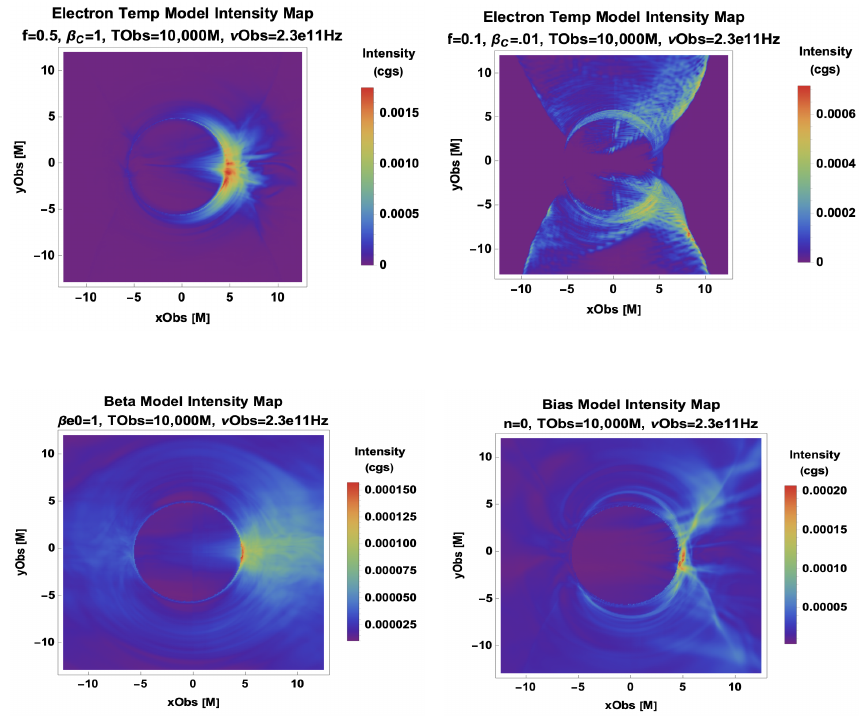
Figure 5. Semi-MAD simulation [9] models that were ray traced at 230 GHz at T = 10,000 M : ( Top Left ) best-fit Critical Beta model ( Top Right ) R Beta with ( f , β c ) = ( 0.5,1 ) ; ( Bottom Left ) Constant Electron Beta model with β e 0 = 1; ( Bottom Right ) Magnetic Bias with N = 0 jet.